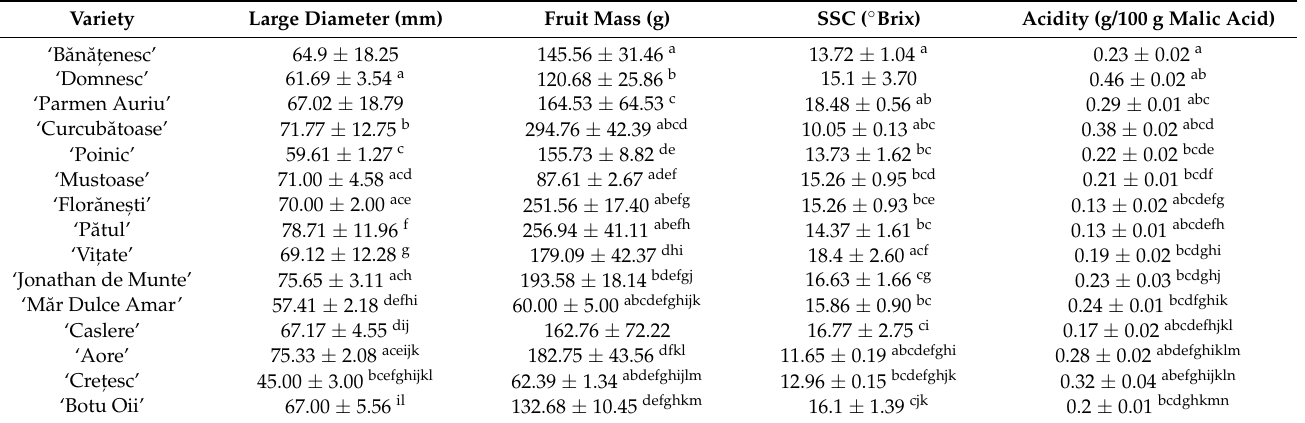
Table 5. The characteristics of the apple varieties after